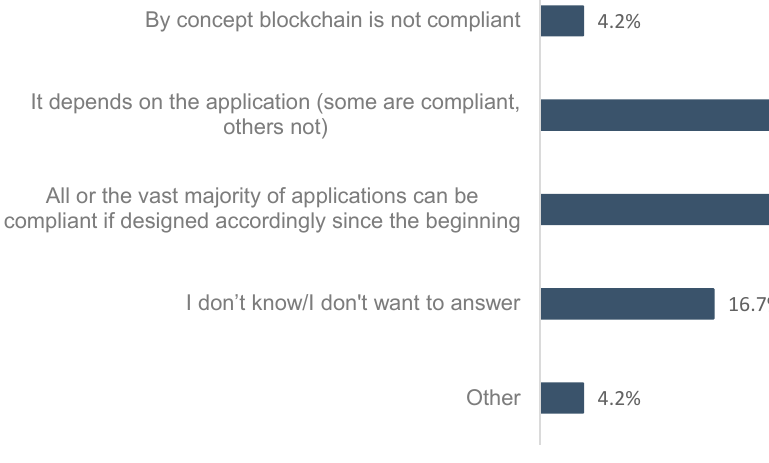
Figure 6. Compliance with regulatory framework.